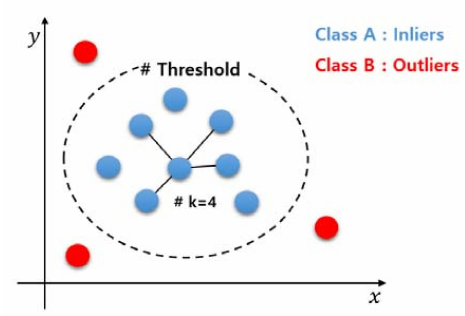
Figure 2. Noise reduction using k-nearest neighbors (kNN)